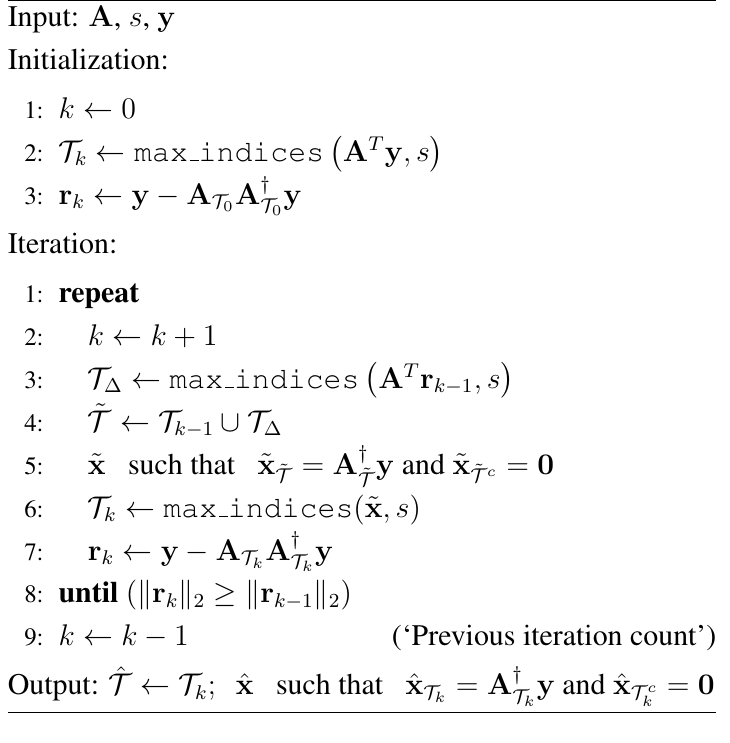
Algorithm 2 Subspace pursuit